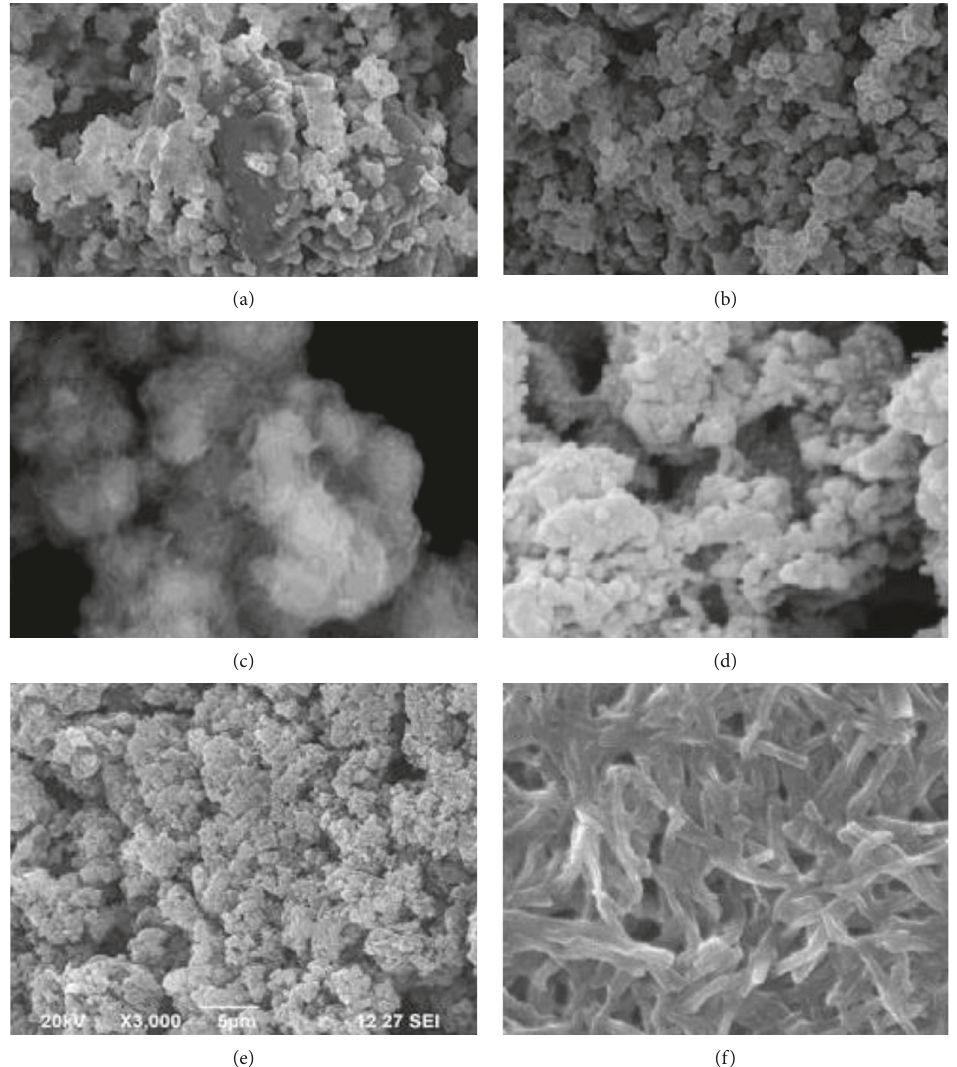
Figure 1: SEM images of polyaniline synthesized at aniline:GA:APS molar ratios of six